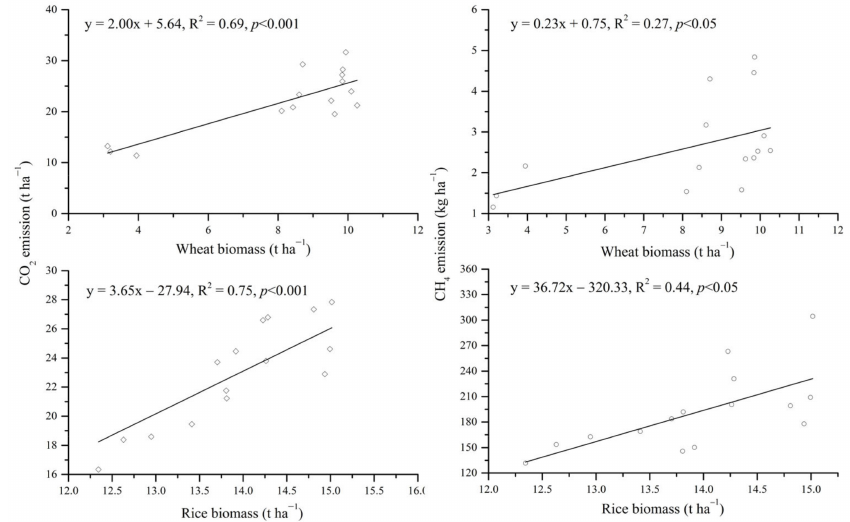
Figure 4. Correlations between wheat and rice biomass with CO 2 and CH 4